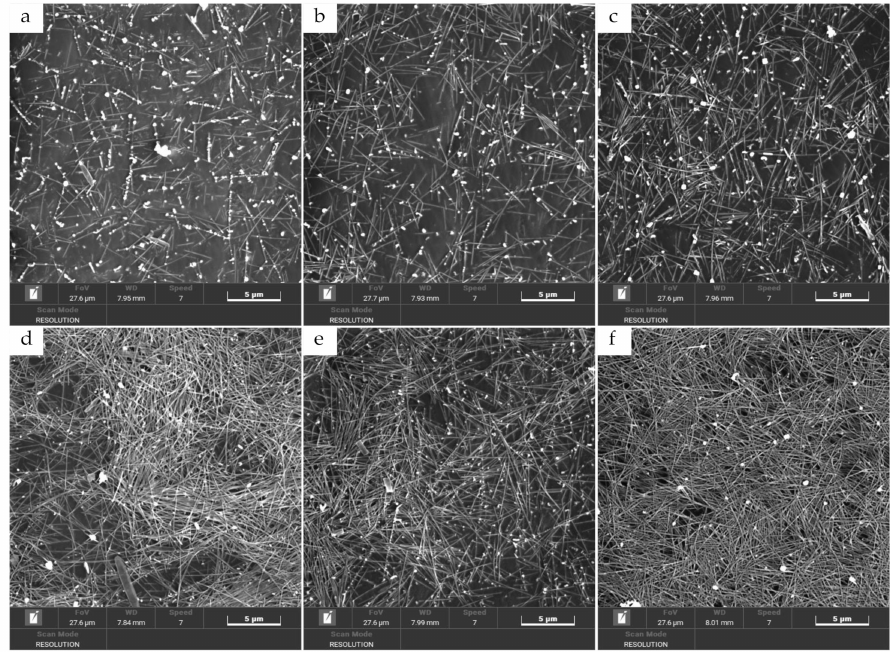
Figure 4. SEM images of AgNWs fims with the printing layers of 3 ( a ), 6 ( b ),9 ( c ), 12 ( d ), 15 ( e ), and 18 layers ( f ),